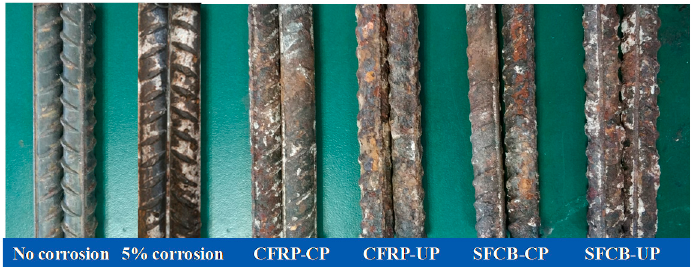
Figure 13. Morphology of the steel bar after the bending test.